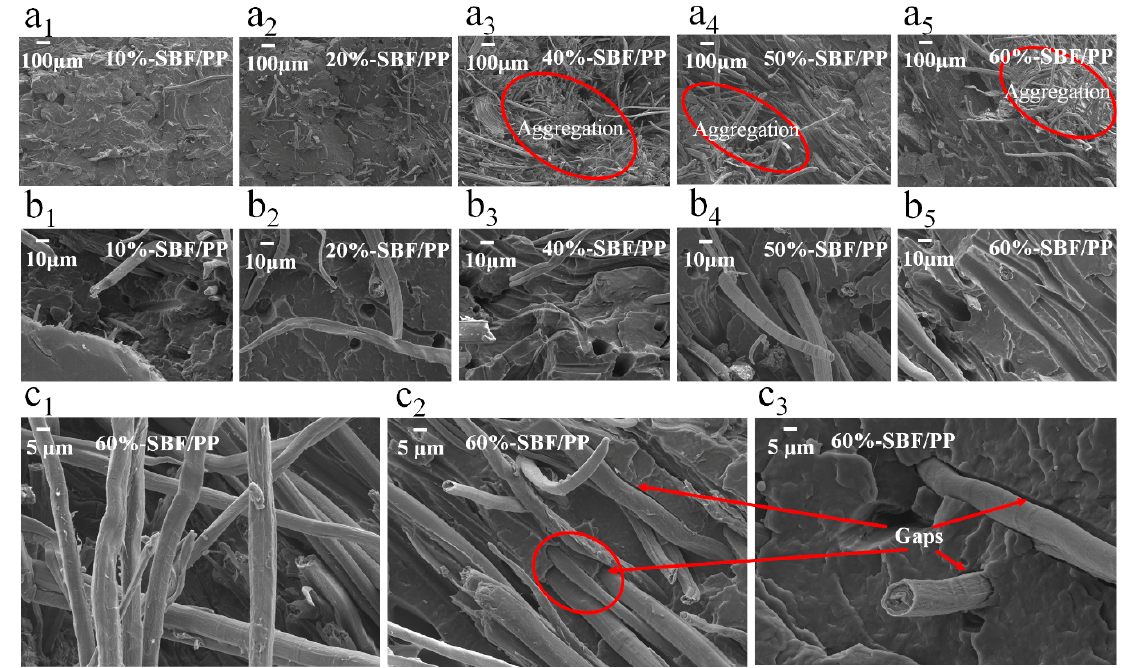
Figure 8. SEM images of impact-fractured surfaces of composites. ( a 1 – a 5 ) SBF / PP with 10% to 60% SBF, magnification 50 × . ( b 1 – b 5 ) SBF / PP with 10% to 60% SBF, magnification 500 × . ( c 1 – c 3 ) SBF / PP with 60% SBFs, magnification 1000 × .